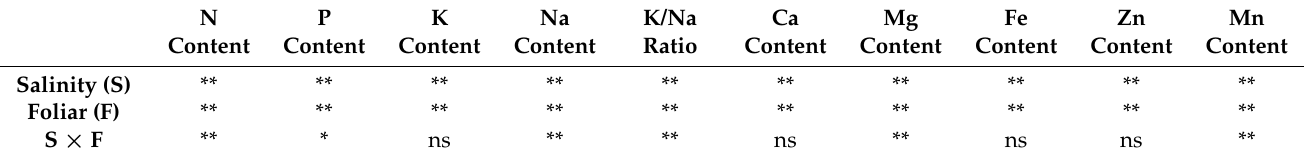
Table 8. ANOVA for the effect of salinity (0–50 and 100 mM NaCl) and foliar applications (no spray, salicylic acid, CeO 2 -nanoparticles, and CeO 2 : SA-nanoparticles) on the elemental content in Portulaca oleracea